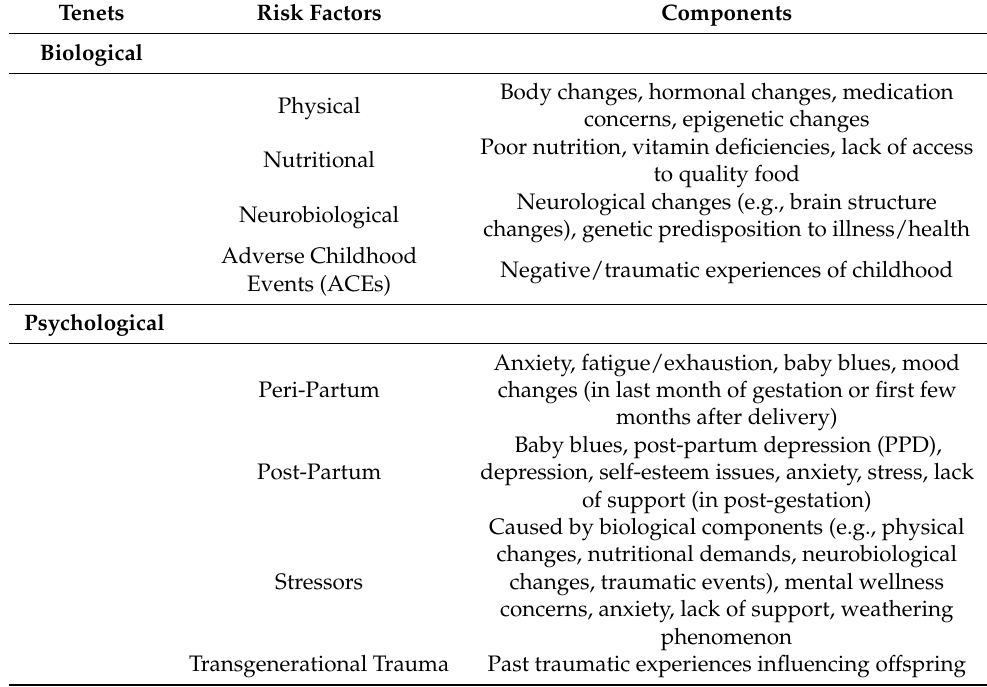
Table 1. Biopsychosocial model of wellness: risk factors for women in pregnancy lifecycles. Tenets